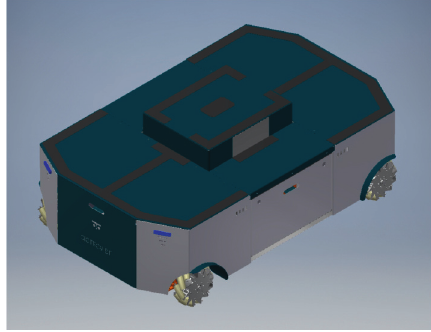
Figure 4: Isometric view of the autonomous guided vehicle.